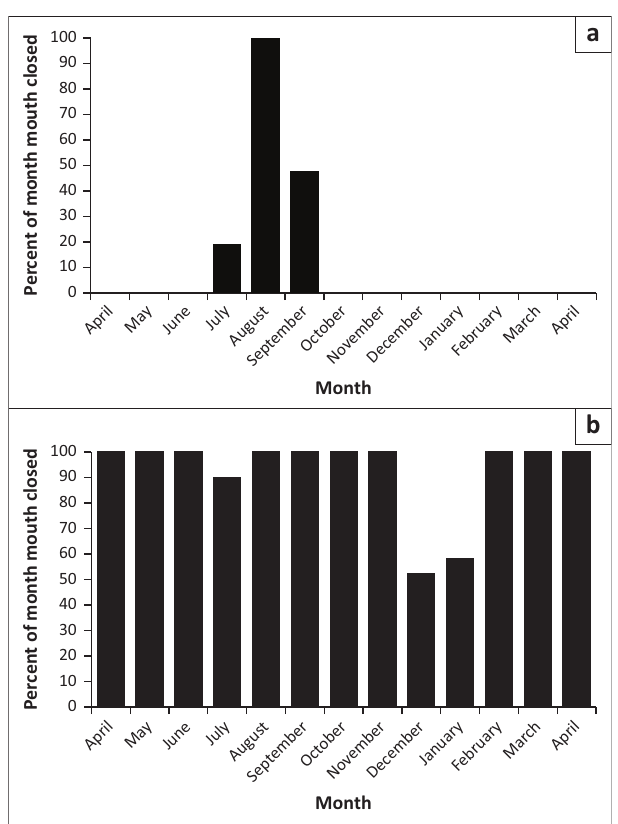
FIGURE 2: Mouth state of the Touw Estuary between (a) April 1982 and April 1983 (Hall 1985) and (b) between April 2010 and April